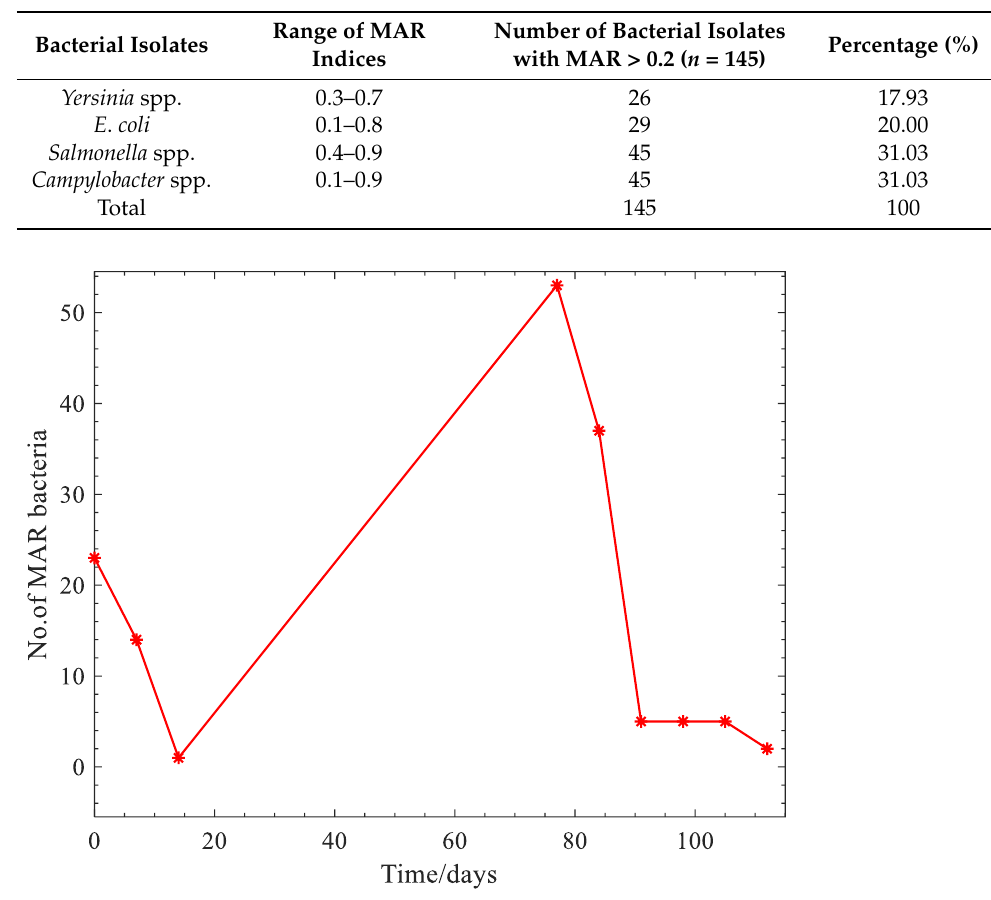
Figure 1. Variation of the number of multiple antibiotic resistant bacteria with time.